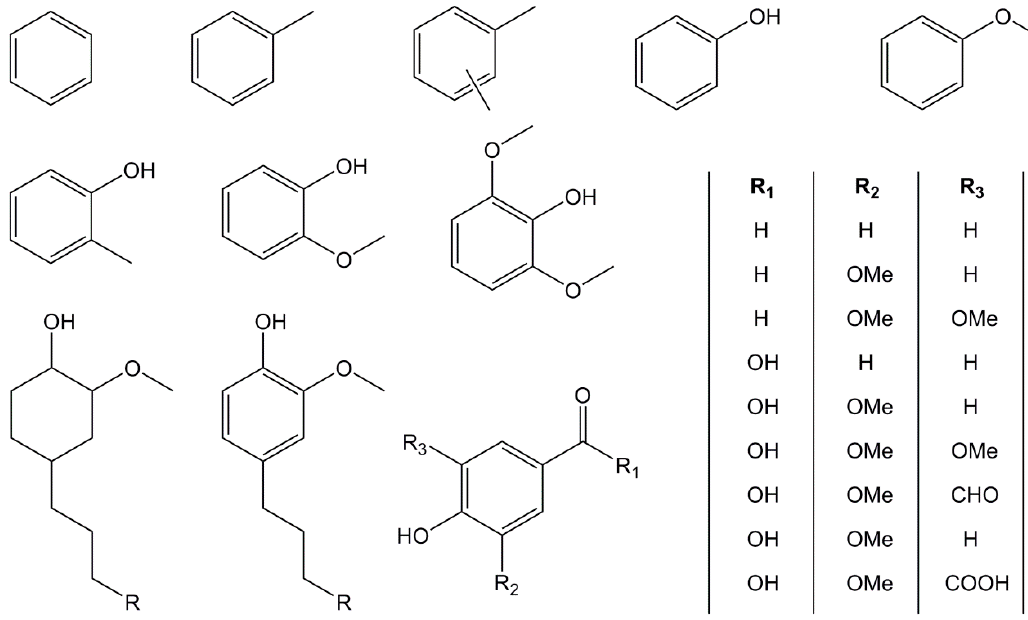
Figure 6. Various aromatic moieties obtained from lignin depolymerization [93,94].